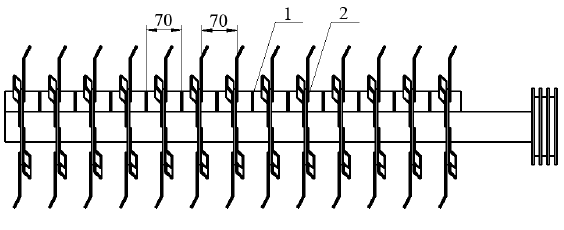
Fig. 7. Schematic diagram of axial moving and fixed cutter arrangement